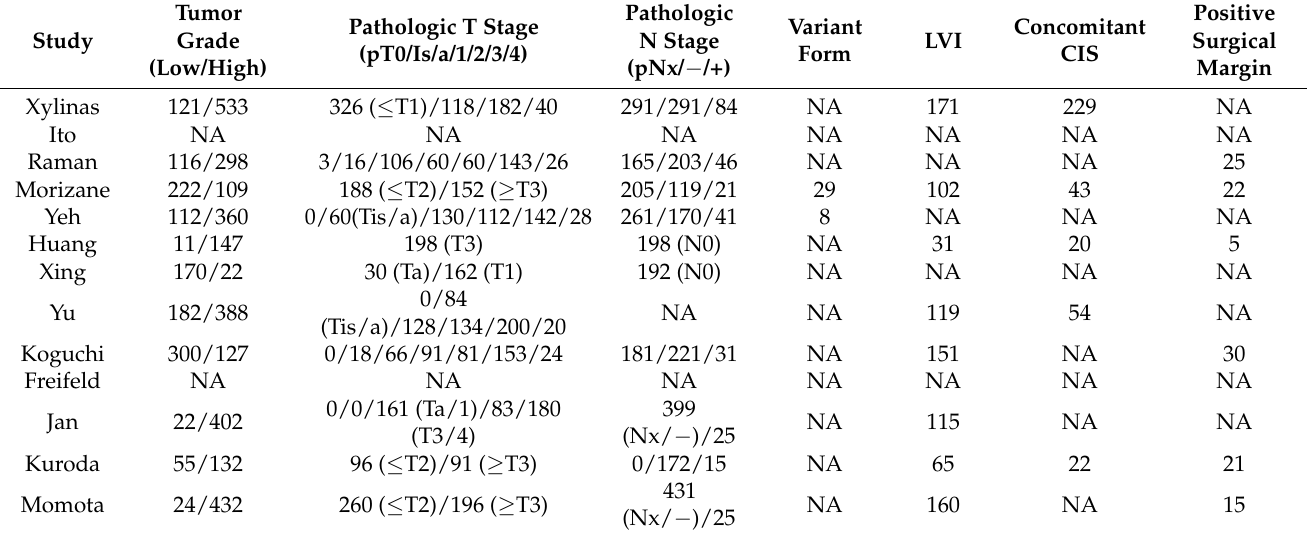
Table 4. Pathologic characteristics of the eligible studies.